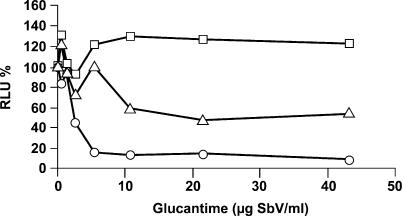
Parasite Susceptibility to Glucantime in the THP1 Cell LineParasites expressing the firefly luciferase were used to infect THP1, and the levels of parasites surviving Glucantime treatment were calculated by measuring luciferase activity expressed as percentage relative light unit (RLU %). The average of two independent experiments performed in duplicate is shown. Open circles indicate strain 175 (sensitive); open triangles indicate strain 467 (intermediate resistance); and open squares indicate strain 827 (high resistance).